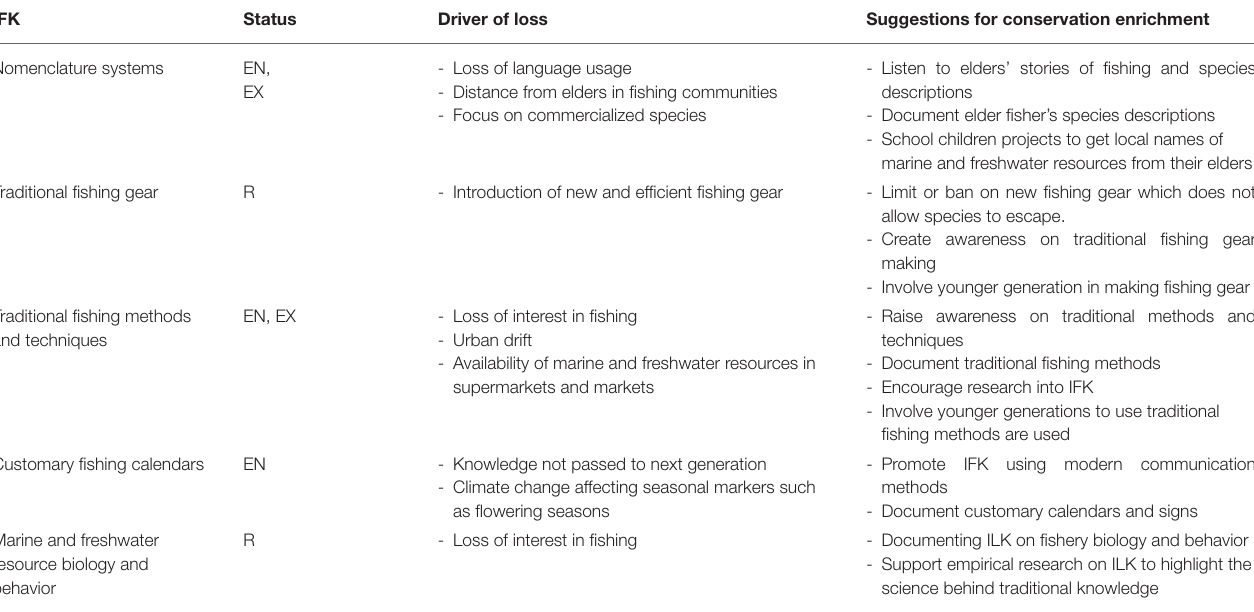
TABLE 3 | Summary of conservation status of marine and freshwater indigenous fisher knowledge (IFK) in Fiji and other Pacific Islands, drivers of loss and suggestions for conservation enrichment.